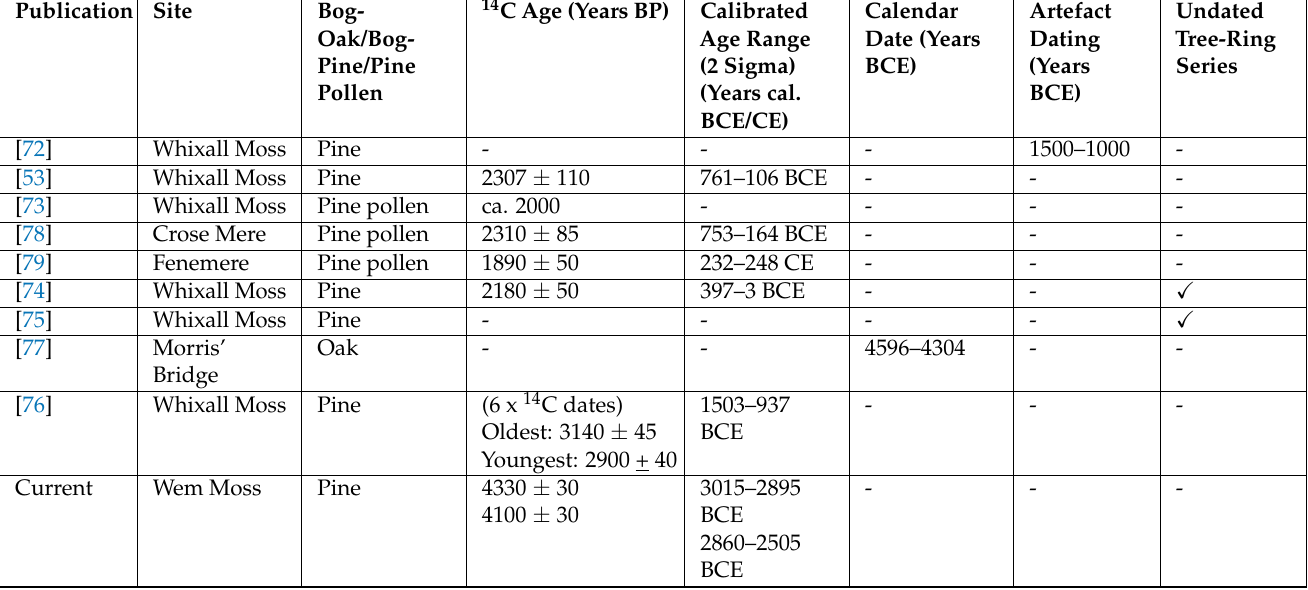
Table 4. Dating associated with subfossil Scots pine and subfossil oak macrofossils and sharp declines in Pinus ( P. sylvestris ) pollen from Whixall Moss and other sites in Shropshire, UK. Calibrations: [84,85]. See also Figure